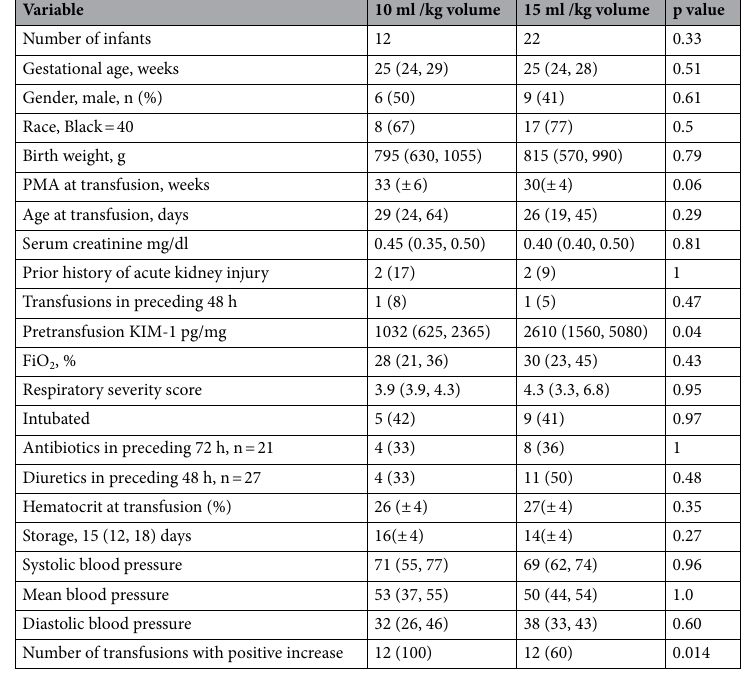
Table 2. Differences in variables between infants that received 10 ml/kg vs. 15 ml/kg blood transfusion volumes. Results were presented as mean (± SD) or median (IQR). PMA post menstrual